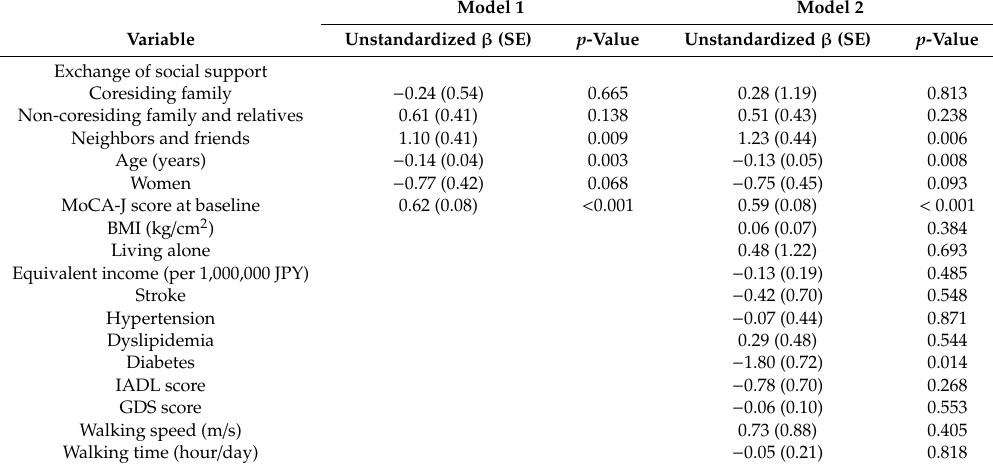
Table 2. The e ff ects of social support on cognitive function at the one-year follow-up. Model 1 Model 2 Variable Unstandardized β (SE) p -Value Unstandardized β (SE) p -Value Exchange of social support Coresiding family − 0.24 (0.54)